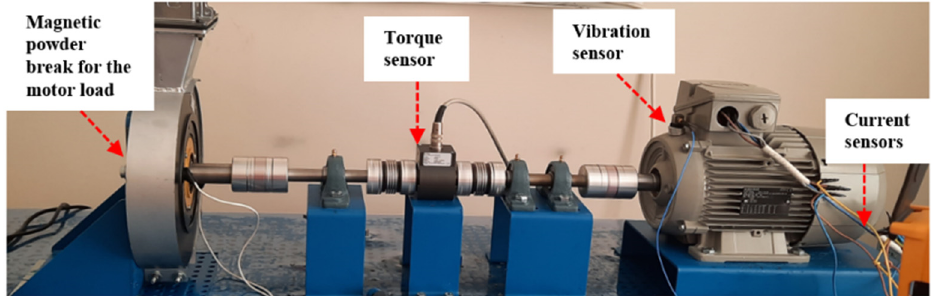
Figure 2. ESOGU in-house testbed setup used to create motor fault scenarios.